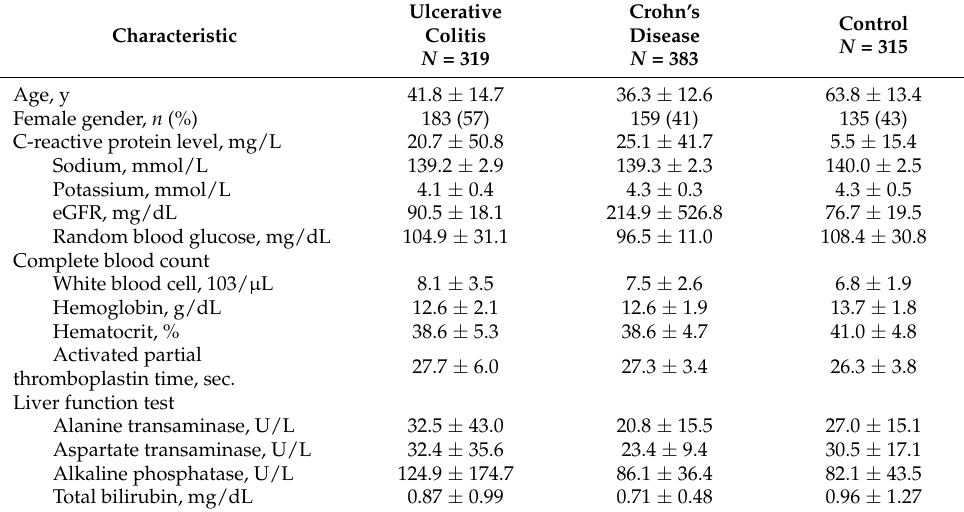
Table 2. Baseline physical examination and laboratory